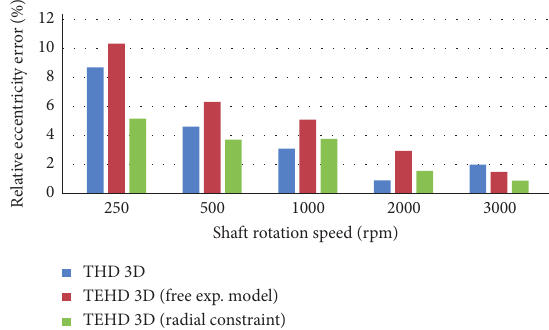
Figure 20: Difference between relative eccentricities measured and computed by means of 3D models for the modified RK in con- figuration 1.